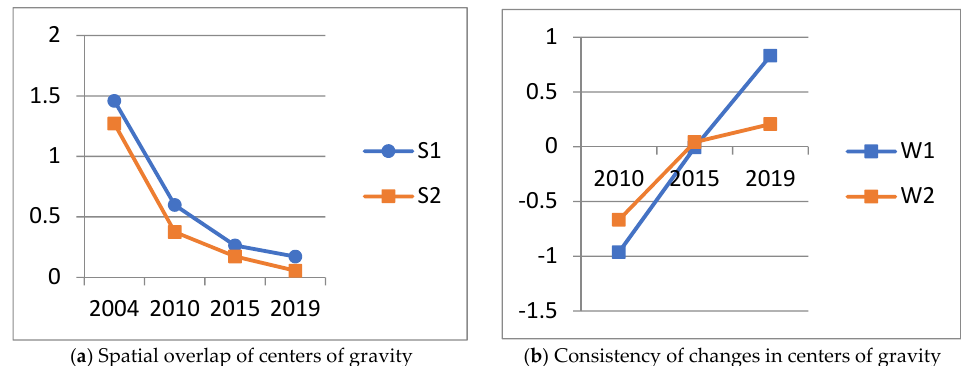
Figure 7. Changes in the spatial overlap and consistency of change indices of technological innovation and environmental pollution in the YRD.